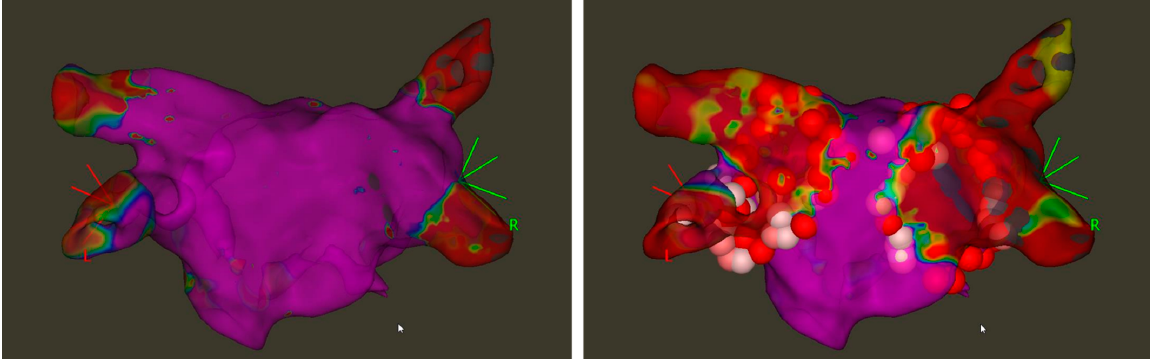
Figure 1. Ablation of the pulmonary vein with high-power short-duration (HPSD), pre- ( left ) and postablation ( right ) electroanatomical voltage map, 0.2–0.5 mV, posterior–anterior view with CARTO.